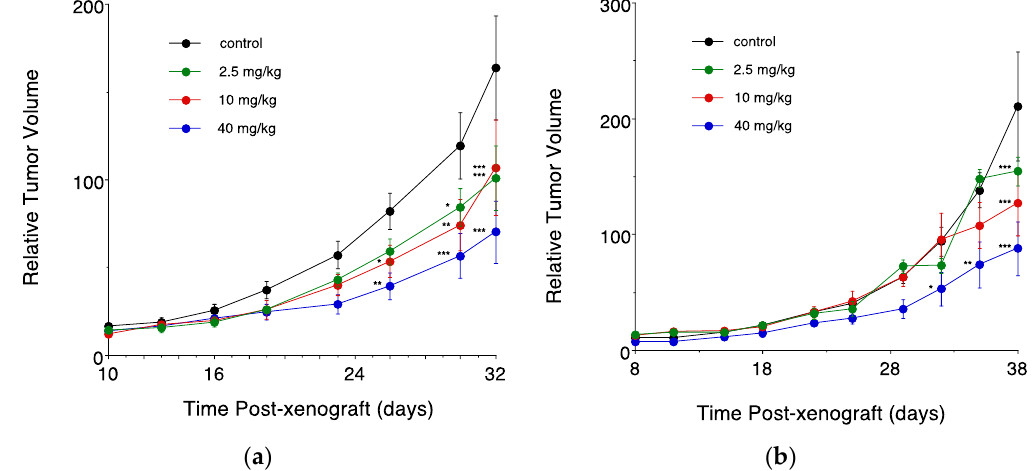
Figure 4. Dose-dependent effects of ClFPh-CHA on the in vivo growth of MDA-MB-231 cell xenografts. ClFPh-CHA was delivered orally as a nanoemulsion ( a ) or by intraperitoneal injection as a solution ( b ). Control groups in each experiment received vehicle only. Different from control: *** P < 0.001, ** P < 0.01, * P < 0.05. (Panel ( b ) reprinted with permission from [10]. Copyright (2017) American Chemical Society.